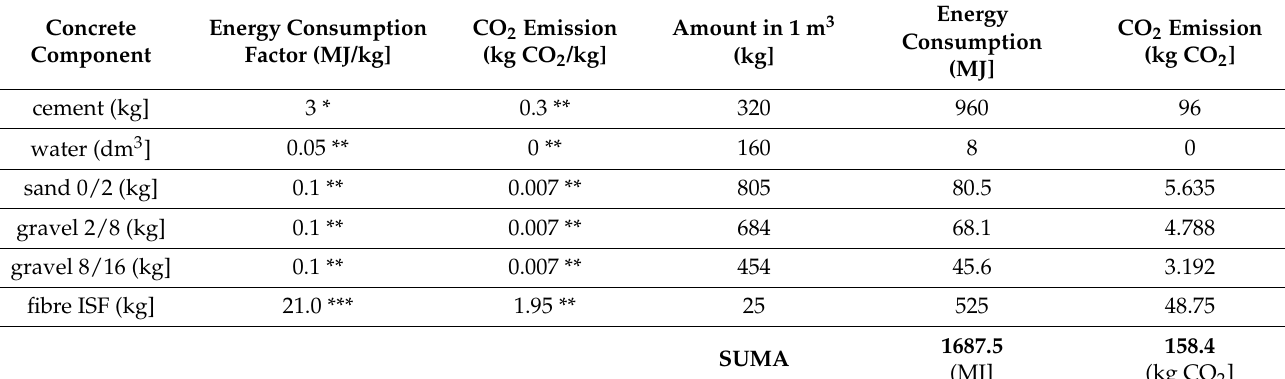
Table 8. Determination of energy consumption and CO 2 emissions for 1 m 3 of fibre concrete with ISF